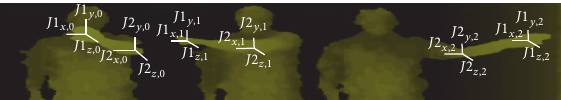
Figure 3: Position of two joints across three frames.